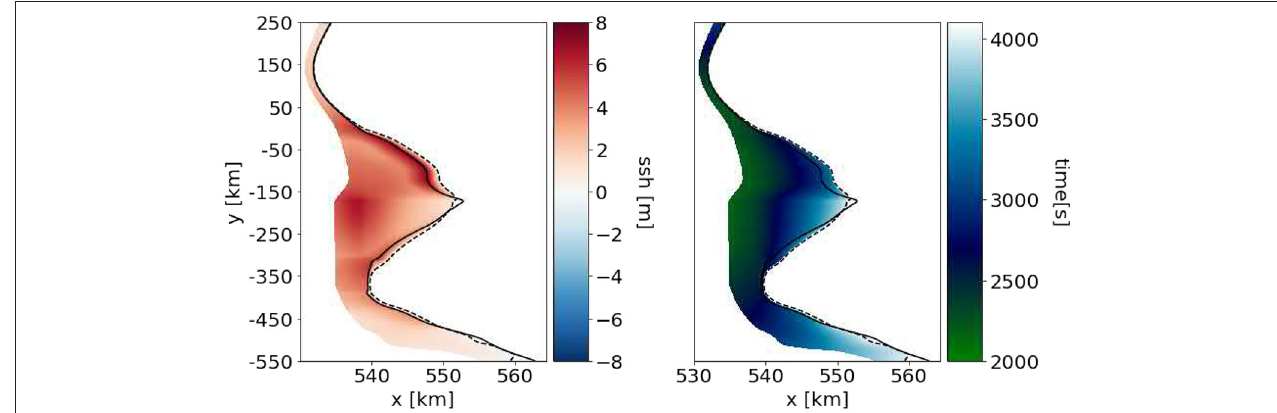
FIGURE 8 | Sea-surface height of the waves at the coast ( left ) and inundation area and time ( right ) for the tsunami scenario with a complex coast ( Figure 3 , right). Note the different x-axis scale compared to Figure 7 which is necessary to resolve the complex coastline at the beginning of the simulation (solid black line) accurately. The dotted line illustrates how far in-land the tsunami